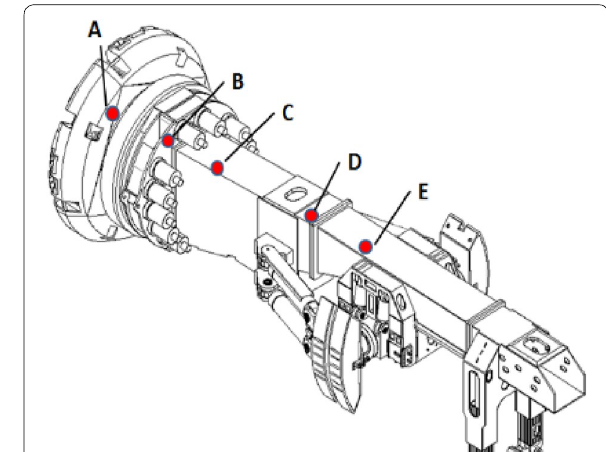
Figure 14 Locations of the acceleration sensors